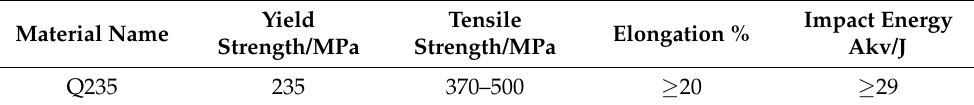
Table 2. Q235 Mechanical